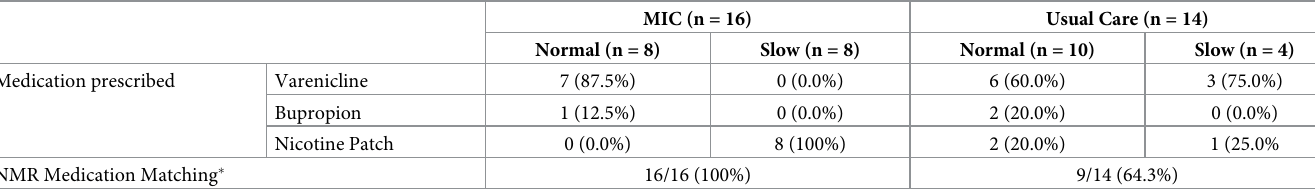
Table 3. Matching of NMR pharmacotherapy by treatment